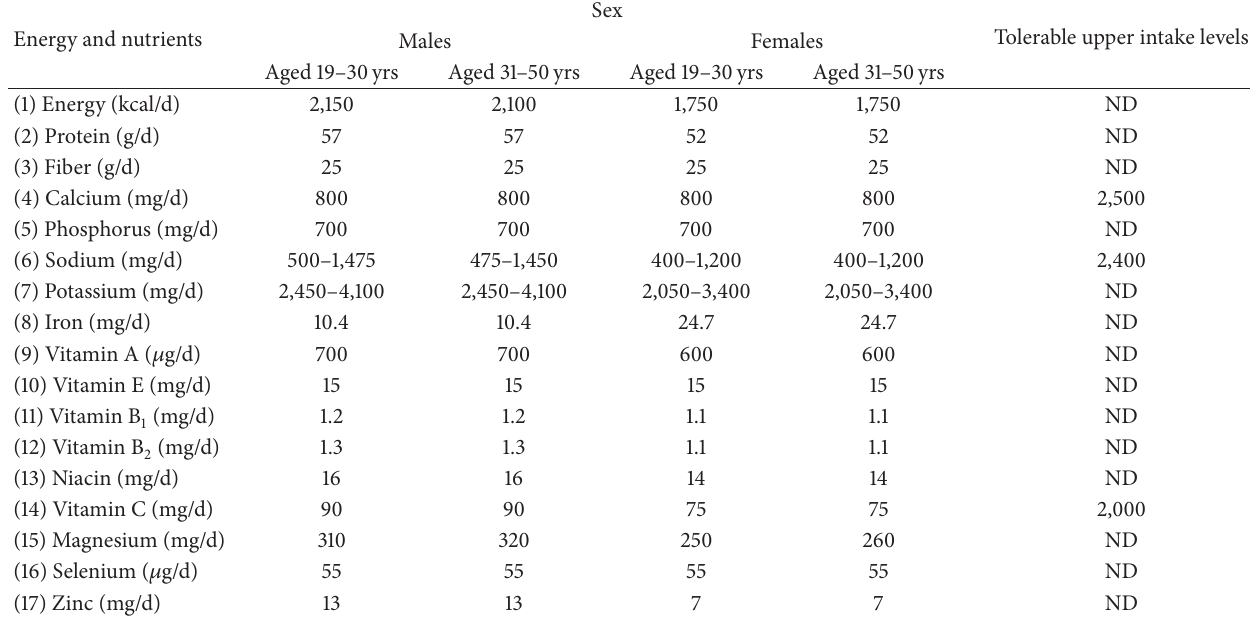
Table 1: The Thai Dietary Reference Intakes (Recommended Dietary Allowances and Adequate Intakes of energy and selected nutrients) for adults aged 19–50